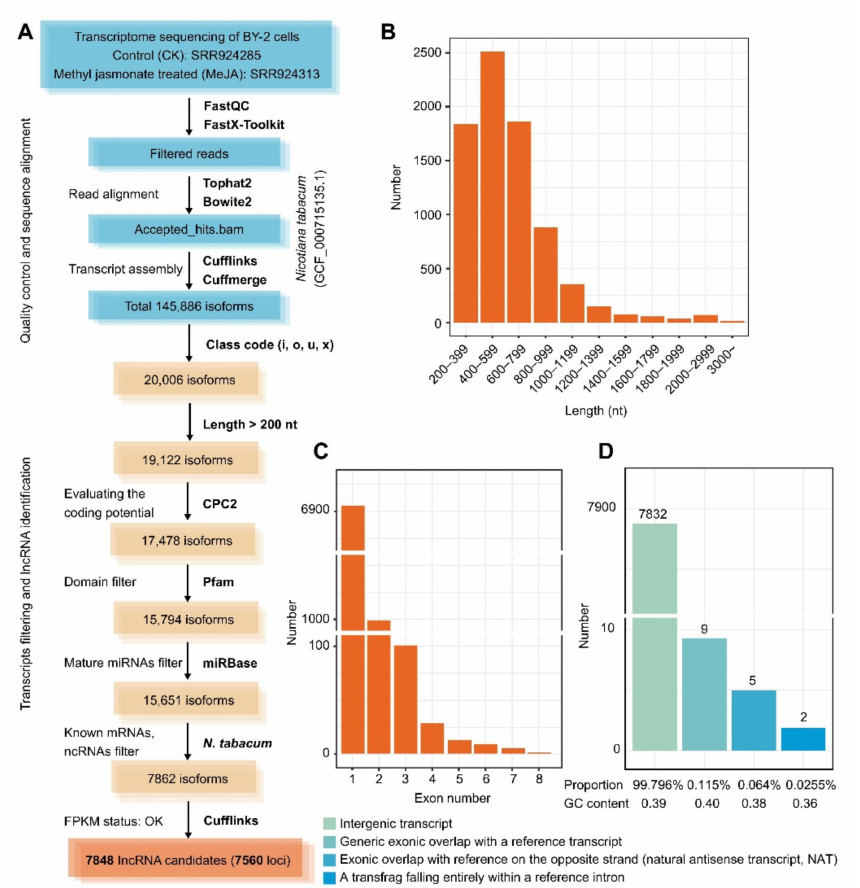
Figure 1. Identification and characteristics of tobacco long noncoding RNAs (lncRNAs) expressed in BY-2 cells. ( A ) General RNA-seq processing and lncRNA identification pipeline in tobacco BY-2 cells. ( B ) Length distribution of 7848 lncRNAs in tobacco BY-2 cells. ( C ) Distribution of exon numbers in tobacco BY-2 cells. ( D ) Classification of lncRNAs according to their location on the genome in relation to neighbouring genes. The columns indicate the number of lncRNAs for each class. The proportions and GC content of the four lncRNA kinds were